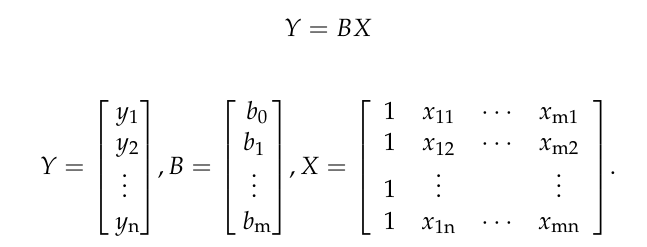
Figure 5. Comparison of fitted and experimental results for tensile strength. Figure 6. Comparison of fitted and experimental results for compressive strength. Figure 7. Comparison of fitted and experimental results for cohesion.